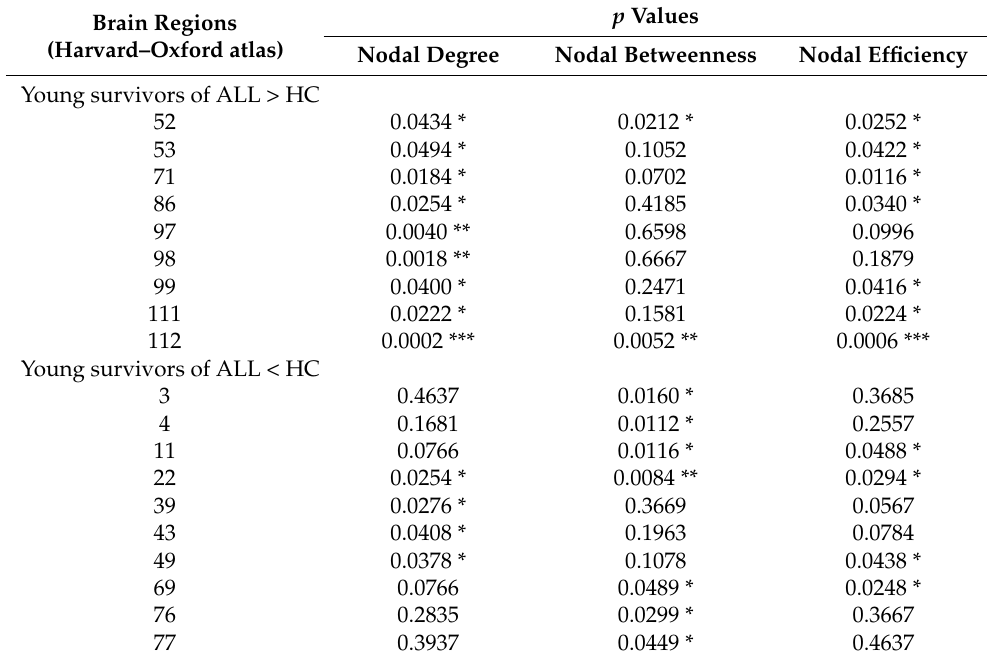
Figure A1. Compared to healthy controls, the young survivors of ALL show hyperconnectivity ( A , interconnected links by red lines) and hypoconnectivity ( B , blue lines) networks. ALL, acute lymphoblastic leukemia; LH, left hemisphere; RH, right hemisphere. Table A3. Regions showing altered node centrality in young survivors of ALL compared to HC participants analyzed using the Harvard–Oxford